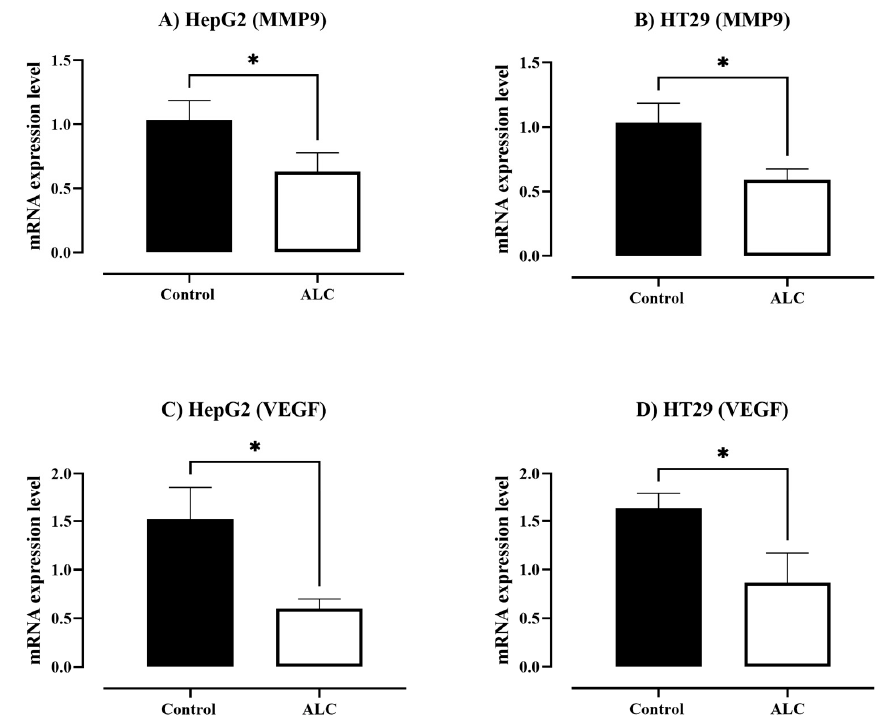
Figure 8. The mRNA expression of MMPs and VEGF in HepG2 and HT29 cells after ALC treatment. ( A ) MMPs mRNA expression levels in HepG2, ( B ) MMPs mRNA expression levels in HT29, ( C ) VEGF mRNA expression levels in HepG2, and ( D ) VEGF mRNA expression levels in HT29. The expression levels of all genes were normalized to that of the β -actin gene. An unpaired t- test analysis was used to compare the expression of each gene compared to the control. Data expressed as means ± SE of three experiments. * p < 0.05 compared to